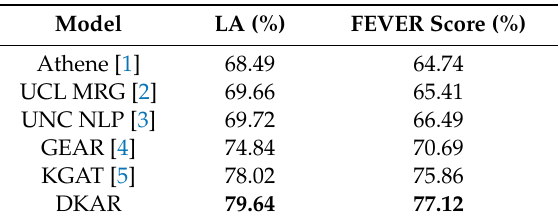
Table 1. Results on the FEVER dev set.